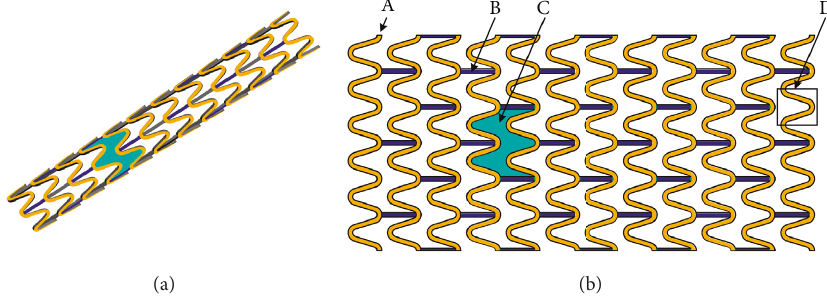
Figure 1: Schematic of the structure of a typical BPS: (a) three-dimensional (3D) model; (b) two-dimensional (2D) model. (A) supporting ring; (B) straight rod-shaped bridge; (C) open cell; (D) supporting element.